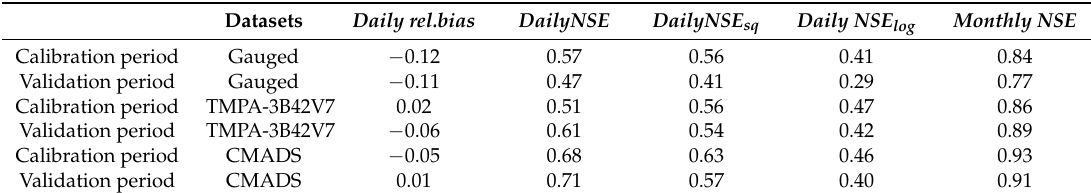
Table 8. Model performance of the Sacramento model (calibrated using NSE ) for the calibration and verification periods.